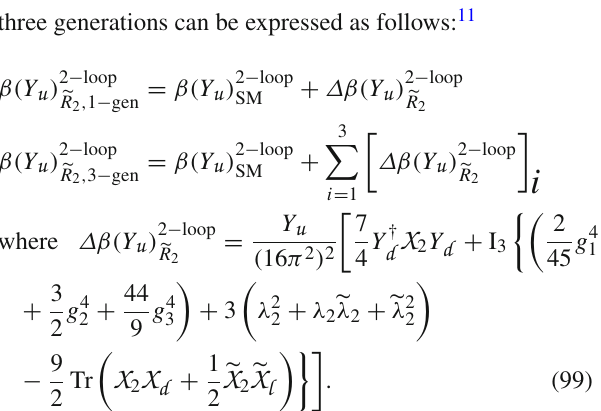
( a ) (b) Fig. 22 Variation in top quark Yukawa with